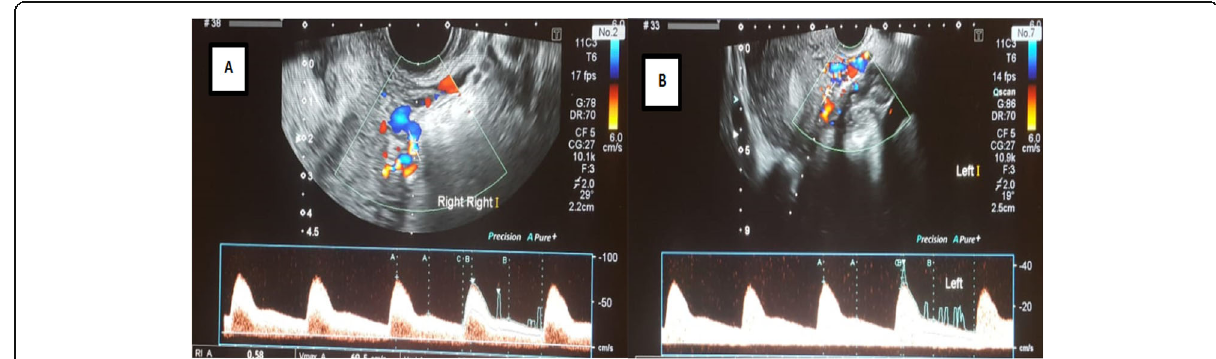
Fig. 4 a , b Transvaginal Doppler ultrasound of both uterine arteries ( a right, b left) of fertile female (control group) aged 25 years old shows RI of right and left uterine arteries were 0.58 and 0.58 with mean RI 0.58, S/D ratios of right and left uterine arteries were 2.49 and 2.36 respectively with mean S/D ratio 2.42, and PI of right and left uterine arteries were 1.1 and 1.96 respectively with mean PI 1.53